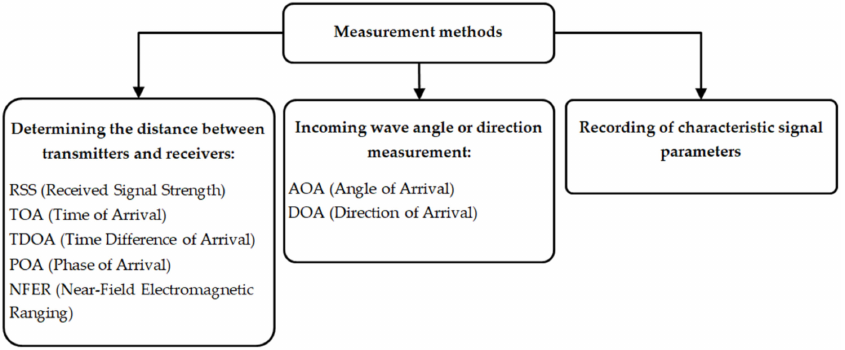
Figure 3. Measurement technologies used in location